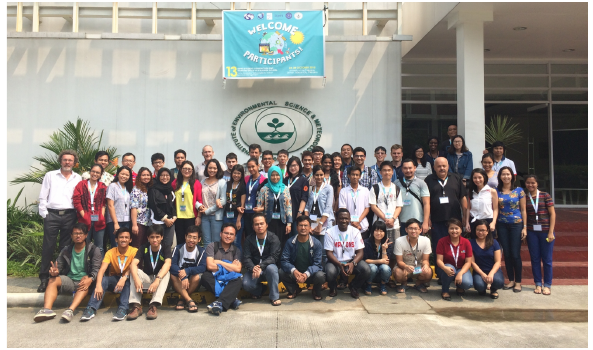
Figure 9. Group photo at the 2015 summer school in the Philippines.